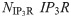
Reaction scheme and IP3R model.The biochemical processes included in the model are illustrated in (A). Cytosolic calcium can exit the cytosol to the extracellular space or the endoplasmic reticulum (ER) at a (total) rate α, lumping together the effects of ER and plasma membrane pumps. Likewise, Ca2+ can enter the cytosol from the extracellular space or from the ER via IP3R-independent flow, with (total) rate γ, emulating calcium channels from the plasma membrane. When an IP3R channel opens, calcium enters the cytosol through the channel at rate μ. Phospholipase Cδ (PLCδ), once activated by calcium binding, produces IP3 at rate δ. Like Ca2+, IP3 can bind the IP3R channel and is removed with rate β. (B) Our model of the kinetics of the IP3R channel is an 8-state Markov model adapted from [46, 56]. Each IP3R channel monomer is associated with 3 binding sites, two calcium binding sites and one IP3 binding site. Occupancy states are designated by a triplet {i, j, k} where i stands for the occupation of the first Ca binding site (i = 1 if bound, 0 else), j for that of the IP3 binding site and k for the second Ca site. The first calcium binding site has higher affinity than the second. The open state is state {110}, where the first Ca and the IP3 sites are bound but not the second Ca site. (C) Spatial parameters for the particle-based model. The NIP3RIP3R molecules are positioned within uniformly distributed clusters, with η
IP3R in each cluster. Hence η = 1 corresponds to uniformly distributed IP3R (no clustering), while the degree of clustering increases with η (for constant total IP3R number). To account for potential co-localization between IP3R-dependent and IP3R-independent calcium sources, the influx of IP3R-independent calcium (at rate γ) occurs within distance Rγ of an IP3R. Thus, low values of Rγ emulate co-localization between IP3R-dependent and IP3R-independent Ca2+ influx sources.